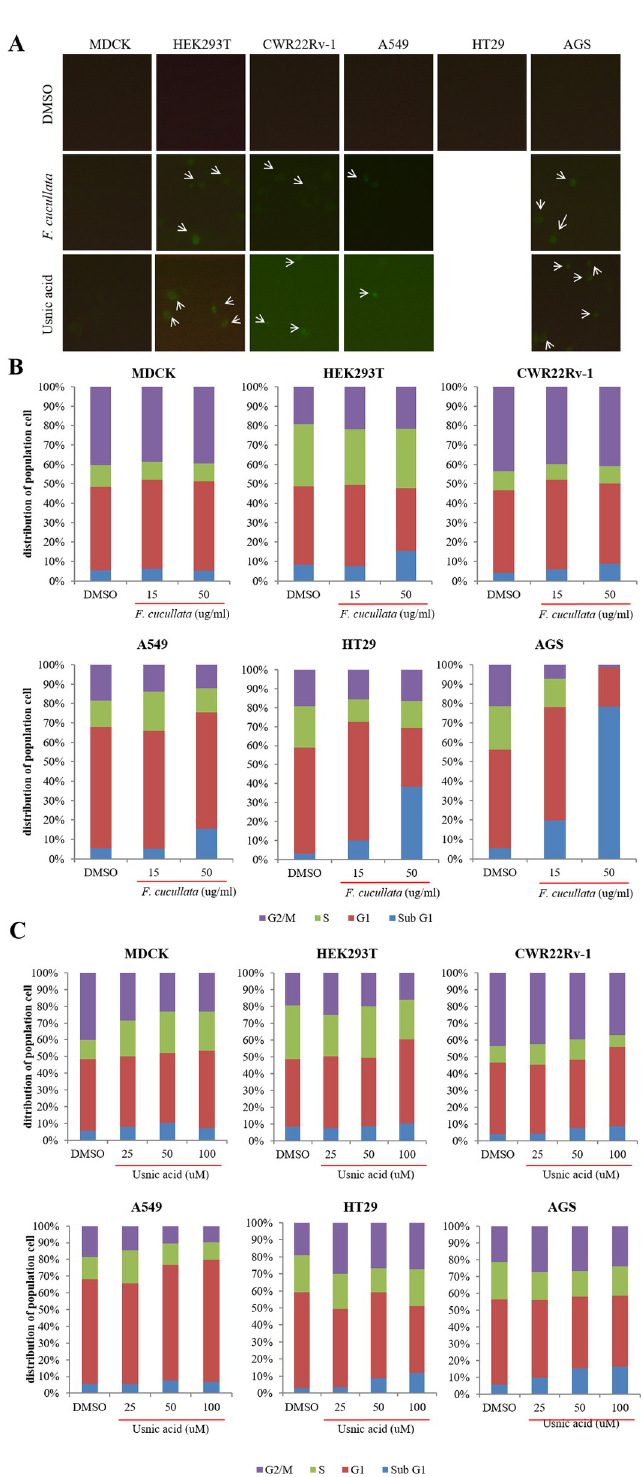
Fig 3. Induction of Annexin V positivity and accumulation of sub G1 population on human cancer cells by the acetone extract of F . cucullata and usnic acid in lethal concentrations. (A) FITC-Annexin V staining of cells treated with the F . cucullata extract or usnic acid. Arrows indicate cells showing FITC positivity. (B–C) Flow cytometric analysis of cell-cycle distributions after F . cucullata extract (B) or usnic acid (C) treatment and graphical representation of the results. Representative images or results are shown from three independent